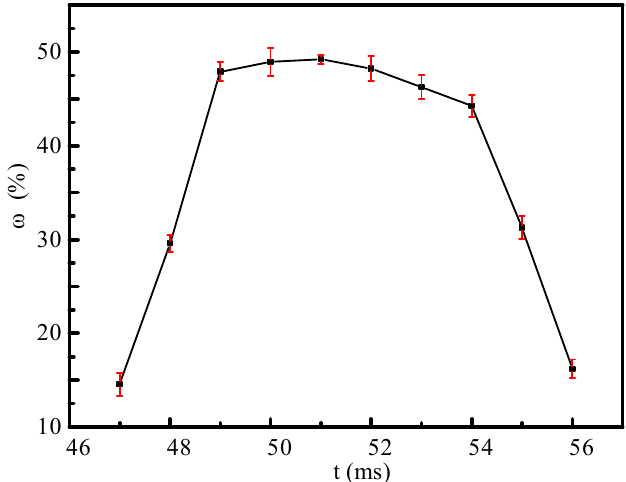
Figure 12. Proportion of secondary flow in the red square.